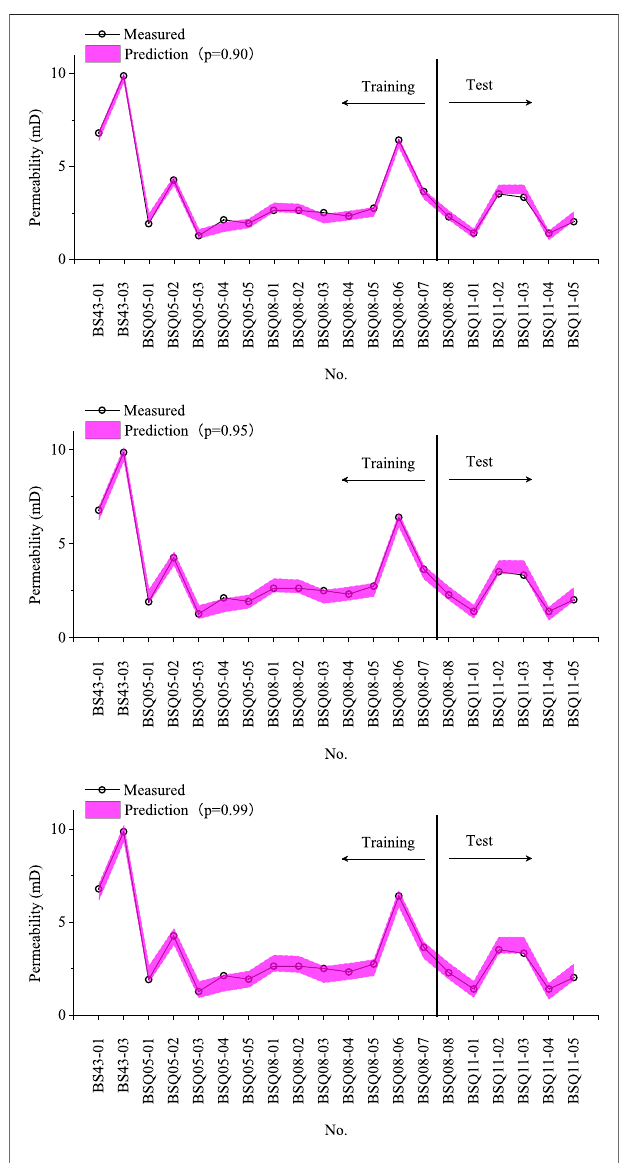
FIGURE 9 | Simulation results of permeability interval